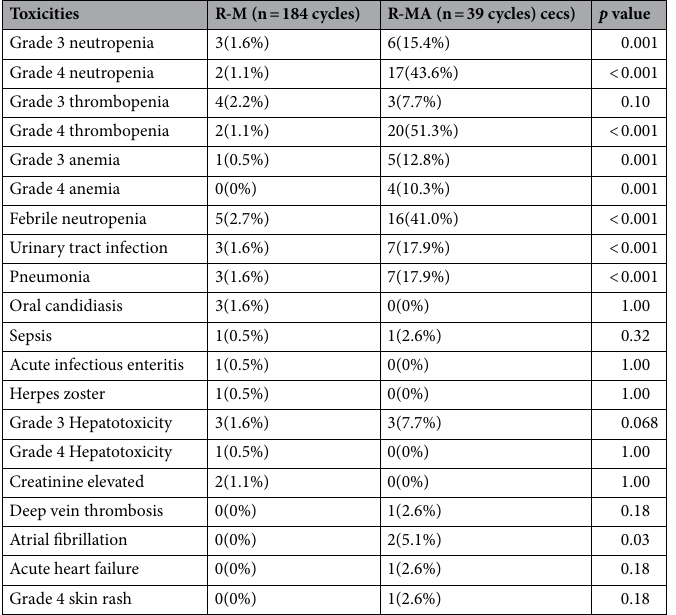
Table 2. Main adverse effects by treatment group. Notes R-M, combination regimen of high-dose methotrexate and rituximab; R-MA, combination regimen of rituximab, high-dose methotrexate and